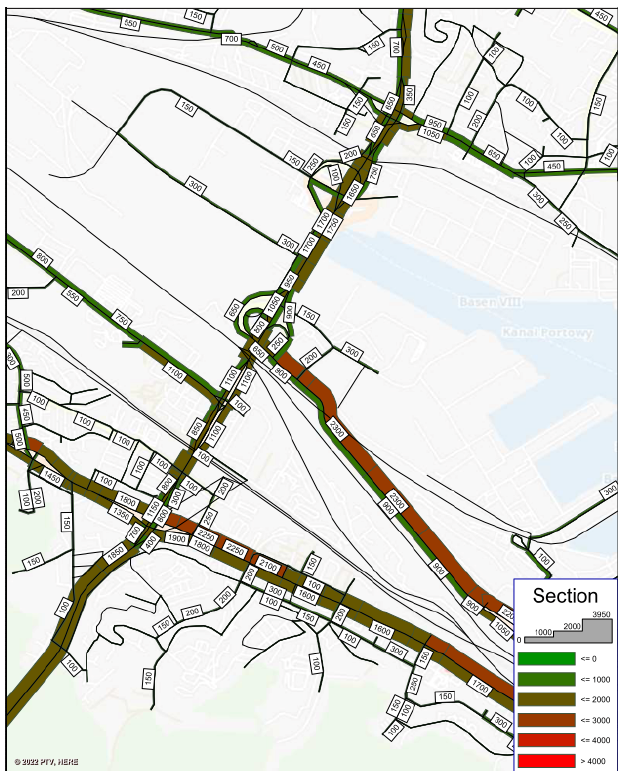
Figure 1. Traffic Flow during PM peak—Gdynia [Source: the model was made available by the Gdynia City Hall—road administration].